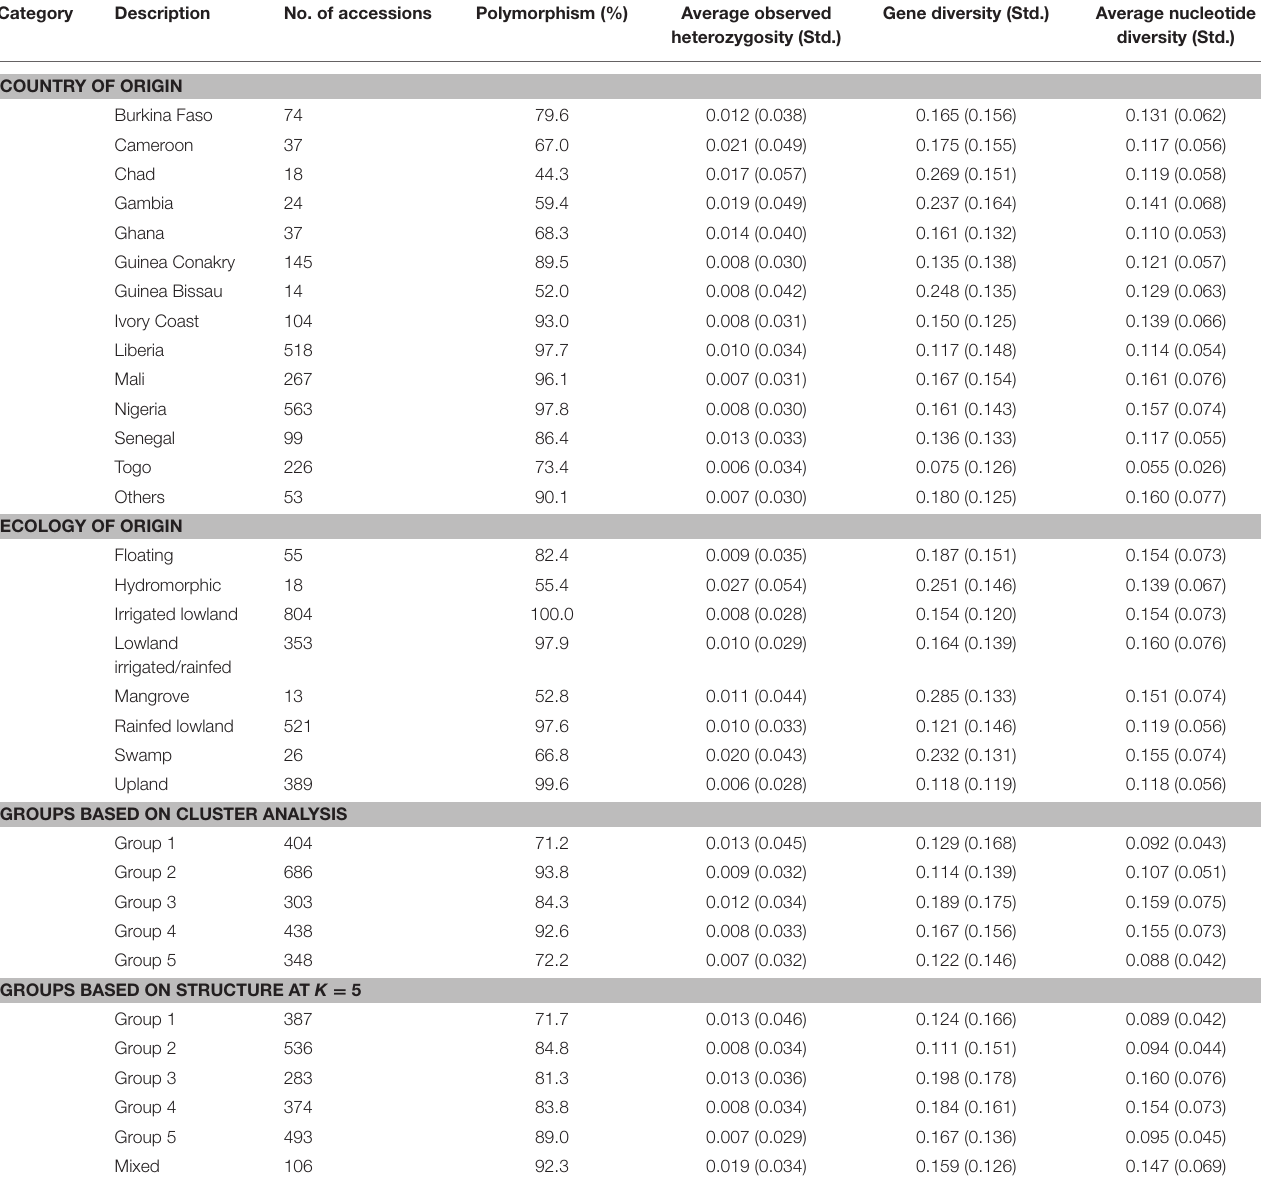
TABLE 3 | Summary of polymorphism and molecular diversity among accessions belonging to different hierarchical levels (country and ecology of origin of accessions plus predicted groups based on the model-based STRUCTURE at K = 5 and cluster analysis). Category Description No. of accessions Polymorphism (%) Average observed